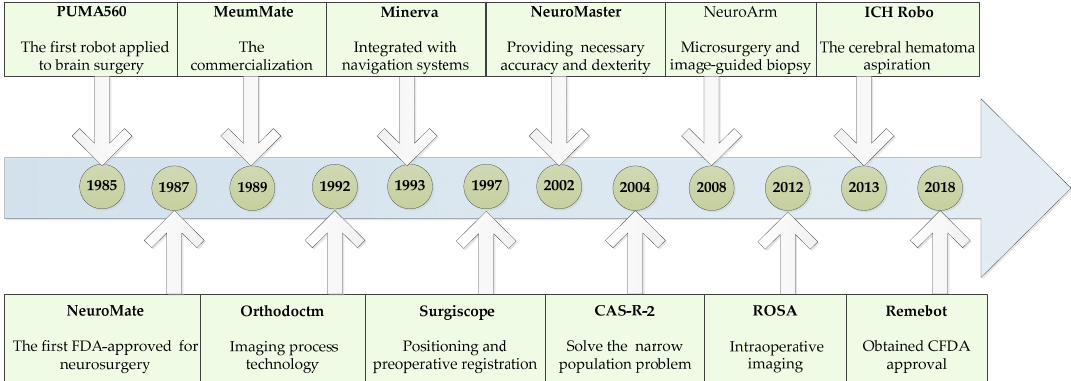
Figure 2. Timeline of a neurosurgical robot and relevant technology.